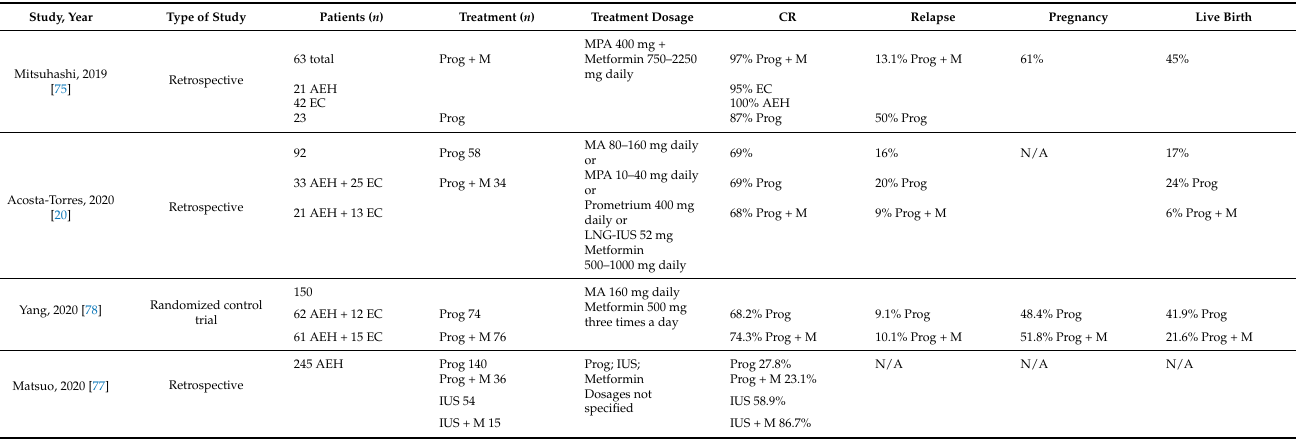
Table 3. Most recent studies on metformin therapy for endometrial cancer and atypical endometrial